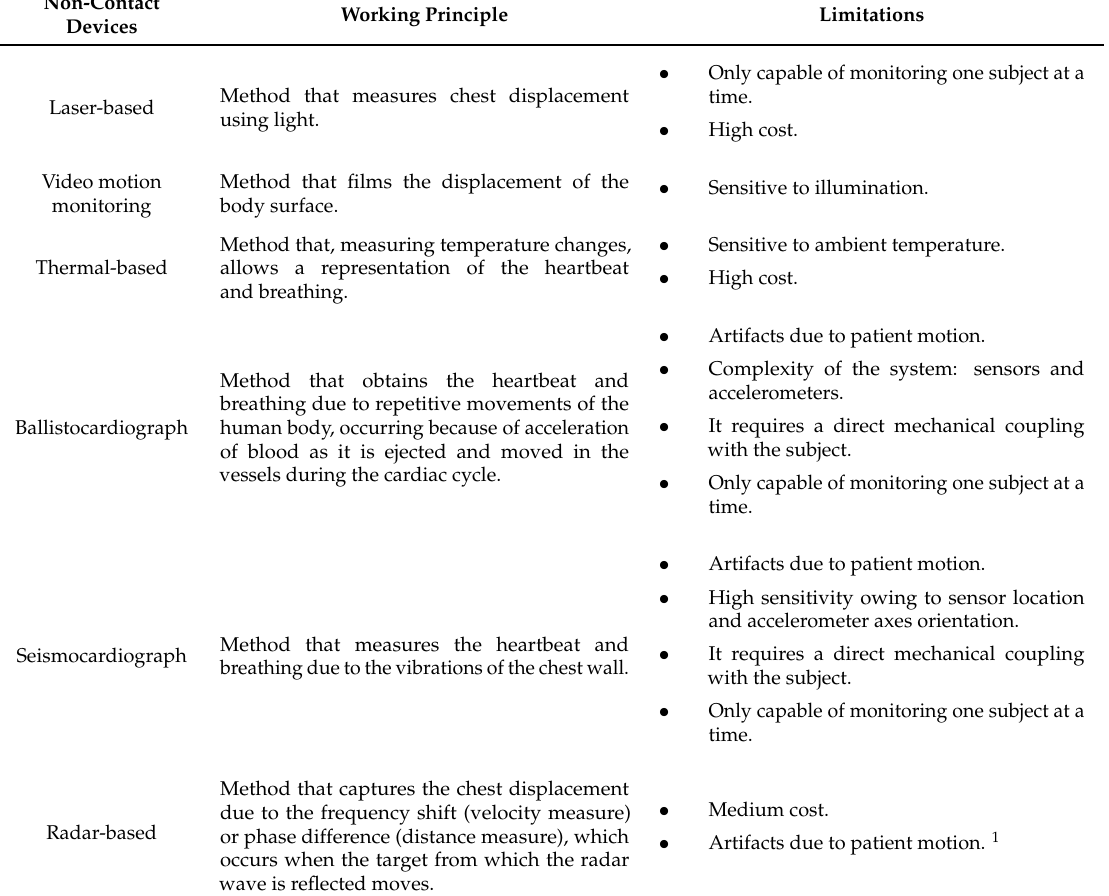
Table 1. Main characteristics and limitations of non-contact devices for cardiorespiratory